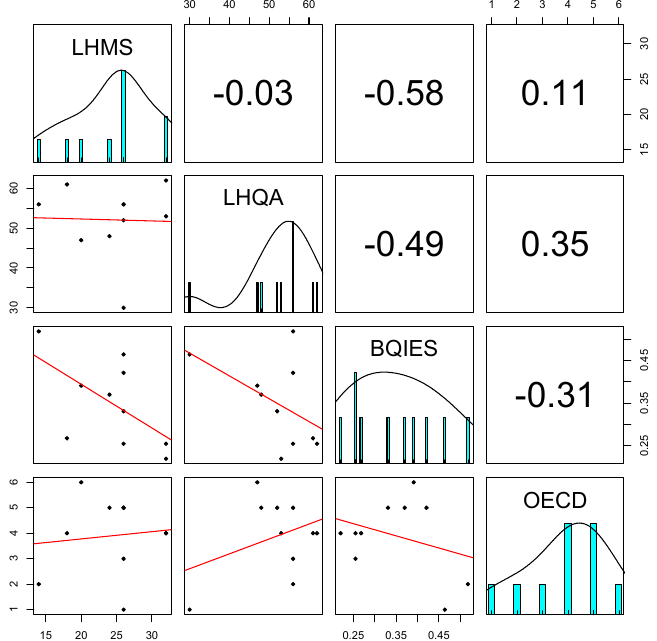
Figure 2. Pairwise comparisons between classification systems: LHMS for habitat modification, LHQA for naturalness, BQIES for macroinvertebrates and OECD for trophic status, ranked in order from 1 as ultra-oligotrophic to 6 as hypertrophic. The diagonal reports the histograms of the distribution of each metric; the values above the diagonal represent Pearson’s r correlation values; the scatterplots below the diagonal show the correlation between pairs of variables with the (non-significant) trend line.